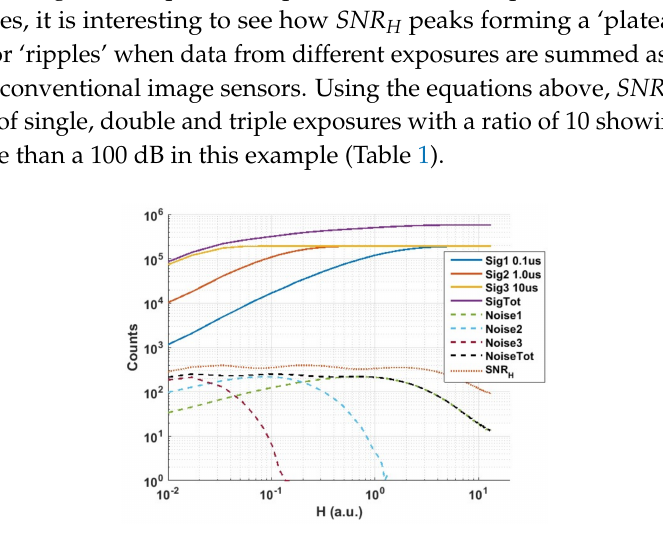
Figure 11. Measured signal, noise and SNR H responses for 3 exposure settings with exposure ratio of 10 and photon threshold K =